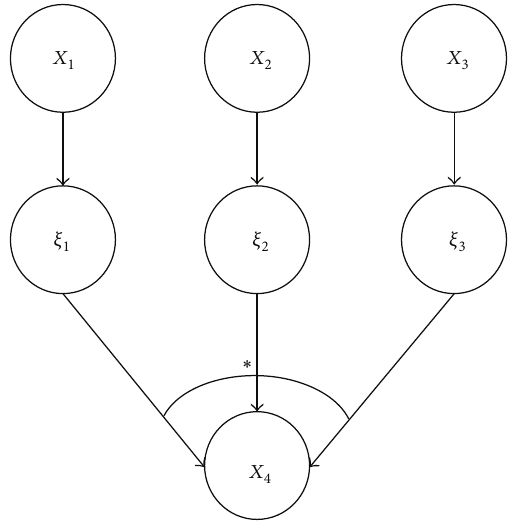
Figure 2: A diagram of independent influence.